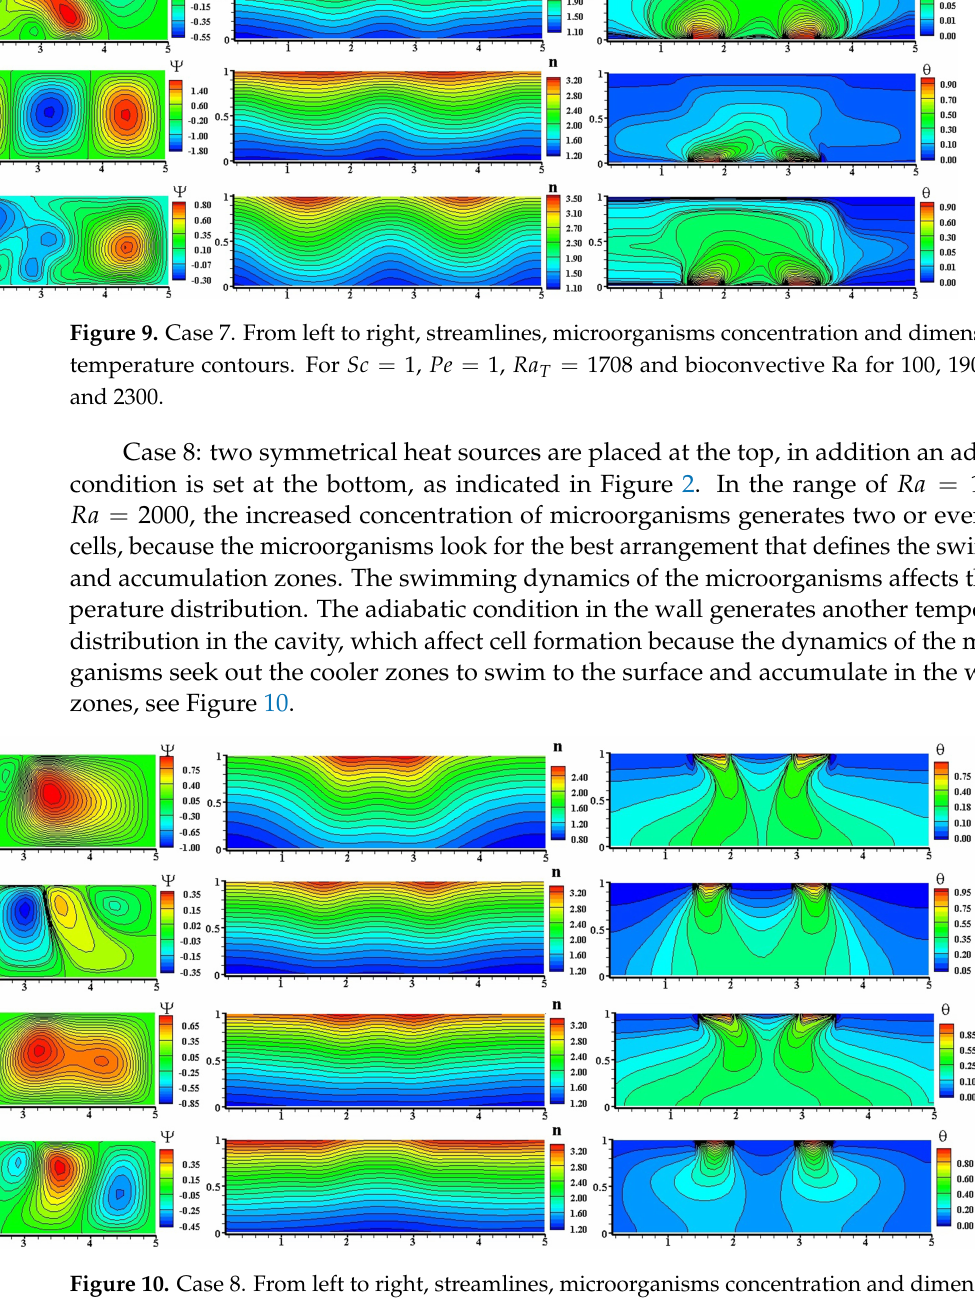
Figure 10. Case 8. From left to right, streamlines, microorganisms concentration and dimensionless temperature contours. For Sc = 1, Pe = 1, Ra T = 1708 and bioconvective Ra for 100, 1700, 1900 and